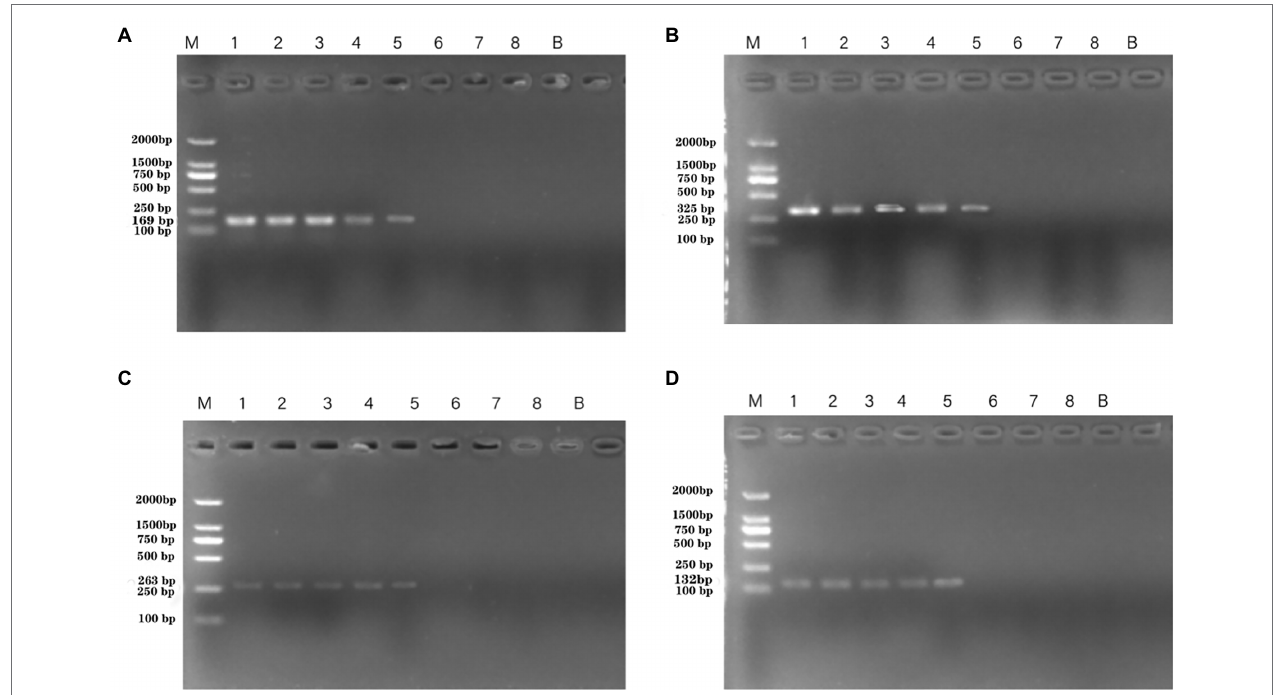
FIGURE 7 | PCR assays using primers targeting P. aeruginosa ATCC 15442 (4.6 × 10 4 CFU/ml) testing for interference with different concentrations of E. coli ATCC 25922. Lane M = DSTM 2000 marker (Dongsheng Biotechnology, Guangdong, China); lanes 1–5 = mixtures of Escherichia coli ATCC 25922 concentration mixed with 1.462 × 10 8 CFU/ml, 1.462 × 10 6 CFU/ml, 1.462 × 10 4 CFU/ml, 1.9 × 10 2 CFU/ml, 0 CFU/ml, respectively. (A) Primer set PA1 (169 bp) mixed with E. coli ATCC 25922; (B) primer set PA2 (325 bp) mixed with E. coli ATCC 25922; (C) primer set PA3(263 bp) mixed with E. coli ATCC 25922; and (D) primer set PA4 (132 bp) mixed with E. coli ATCC